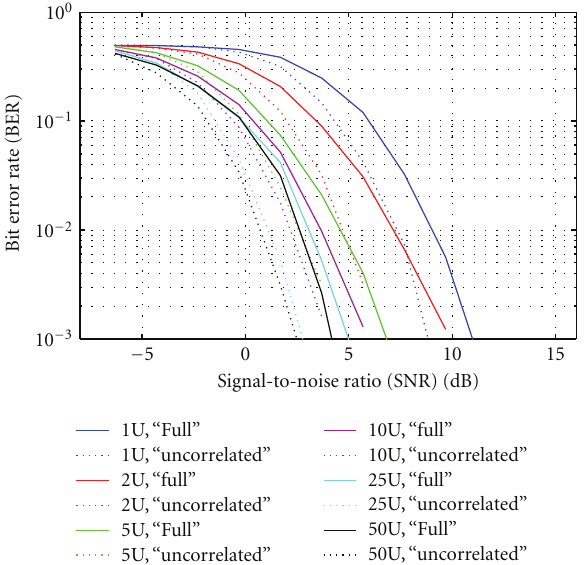
Figure 6: BER performance of an MU-MIMO (partial feedback) with di ff erent number of users.